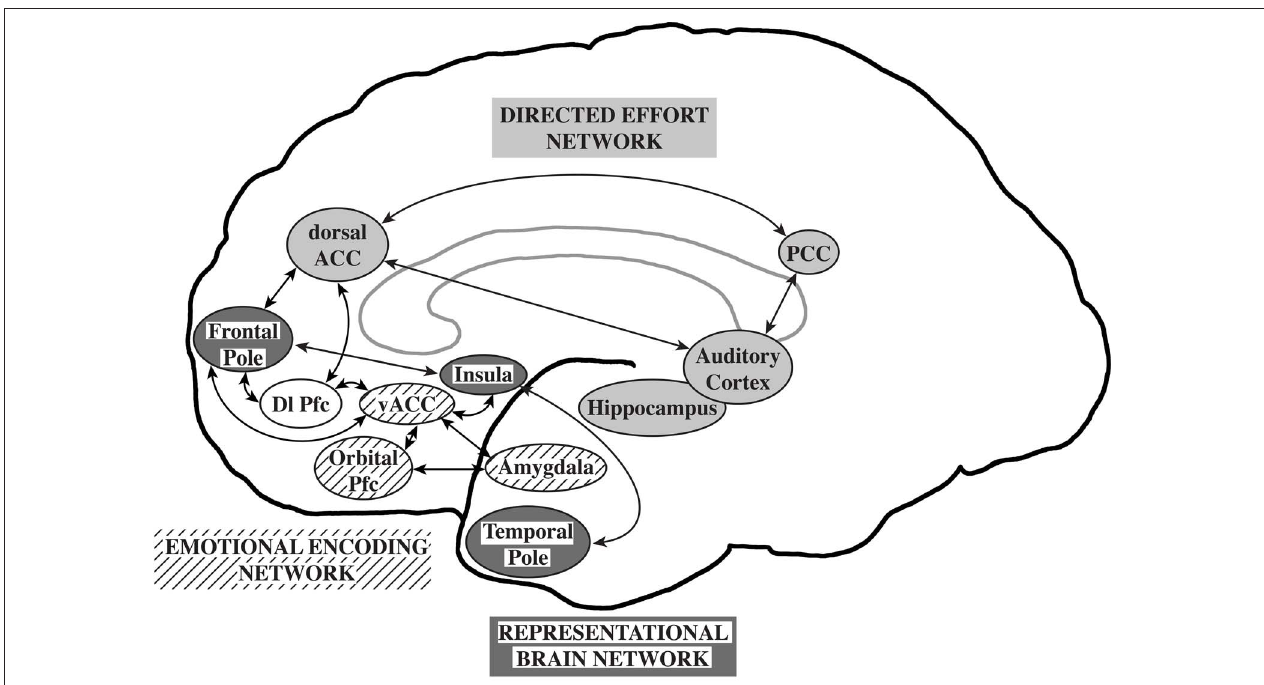
FIGURE 1 | The representational brain. The representational brain network (dark gray), proposed to underlie autism, includes the frontal pole, insula, and temporal pole. The directed effort network (light gray), proposed to underlie schizophrenia, includes the dorsal anterior cingulate cortex (ACC), posterior cingulate cortex (PCC), auditory cortex, and hippocampus. The emotional encoding network (lined), proposed to underlie mood disorders, includes the